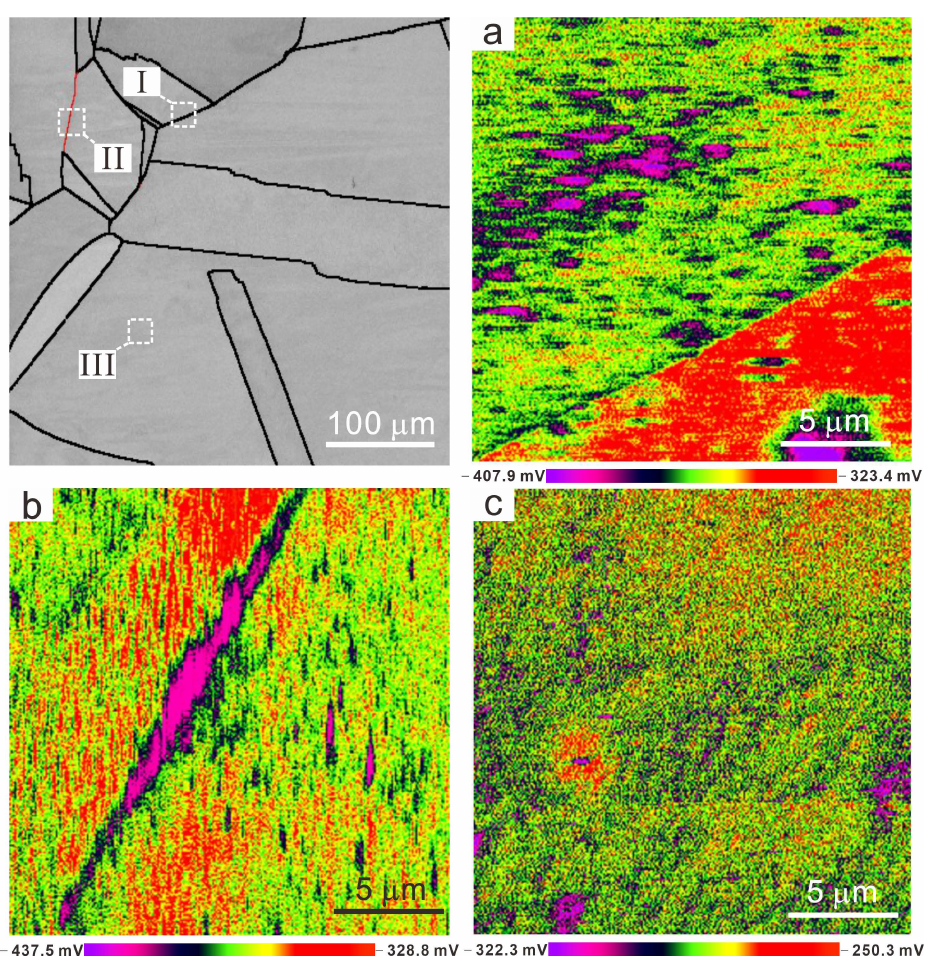
Figure 5. The low-angle grain boundary distribution of undeformed copper and the Volta potential for the selected regions. In the EBSD image of undeformed copper. The Volta potential of regions I, II and III with different grain boundary distribution were measured to obtain the corresponding potential distribution maps ( a ), ( b ) and ( c ).